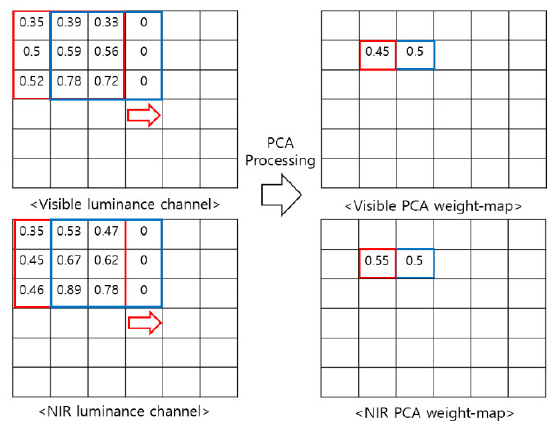
Figure 4. PCA-skipping mask-fusion method.